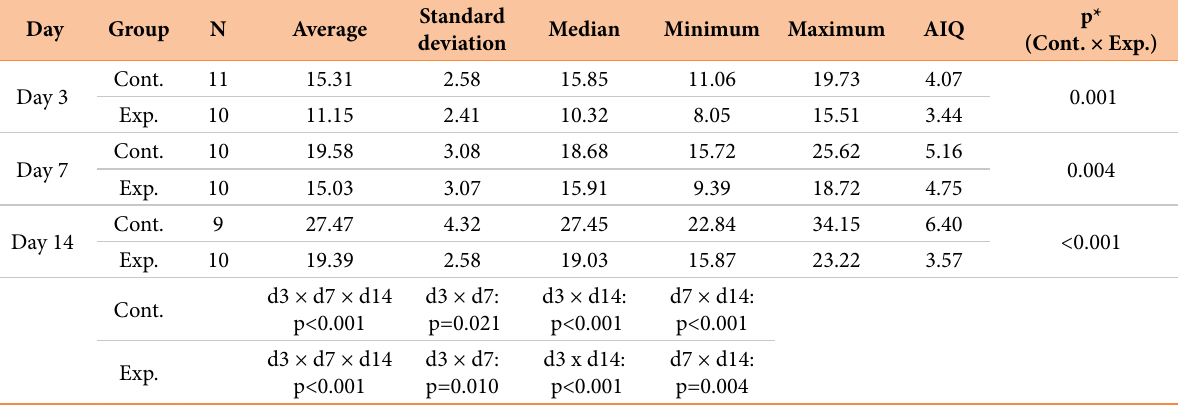
Table 6 - Average area occupied by collagen, using picrosirius-red F3BA.